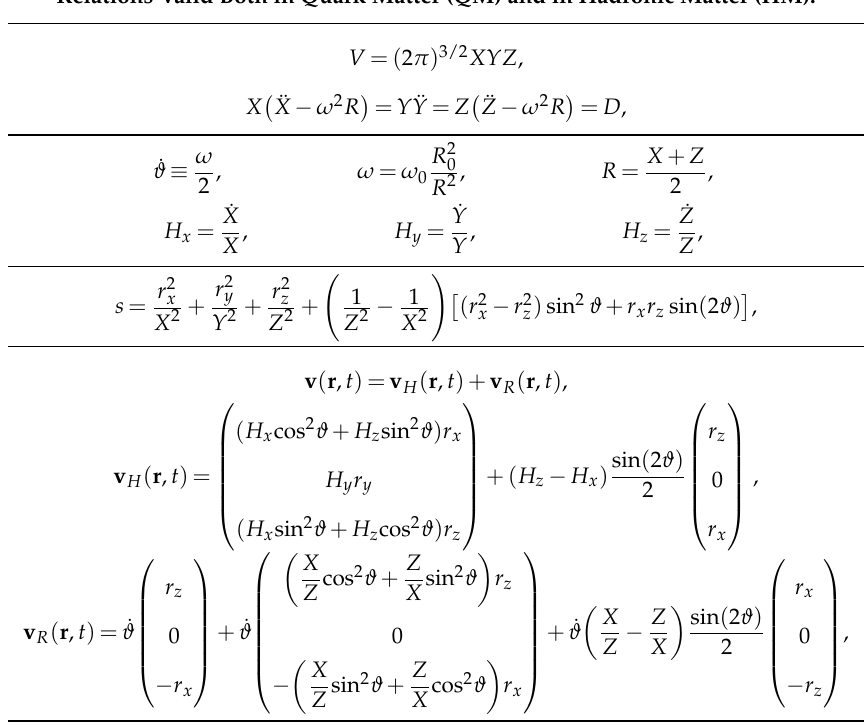
Table 4. Equation of state independent part of new, exact, rotating solutions of fireball hydrodynamics, as given in the laboratory frame K , where a rotating ellipsoid with time dependent principal axis X , Y and Z is not only expanding but also spinning around the r y direction. The time dependent parameter ϑ stands for the angle between the principal axis X and the impact parameter direction, r x in the intertia frame K . The first of this kind of solutions was given in [18], which we generalize in this work to quark matter and multi-component hadronic matter